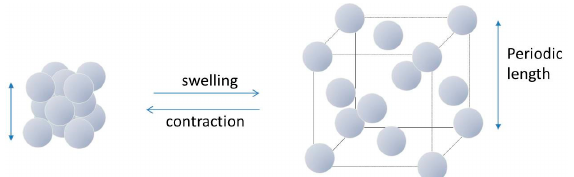
Figure 1. Lattice constant change of 3D photonic crystals (PCs) constructed by self-assembled colloidal particles.